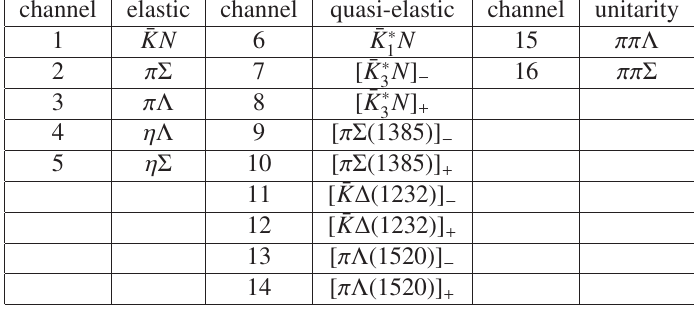
Table 1. The list of interaction channels included in the coupled-channel PWA describing the hyperon system by the Joint Physics Analysis Center (JPAC) Collaboration [7]. See Ref. [8] for its